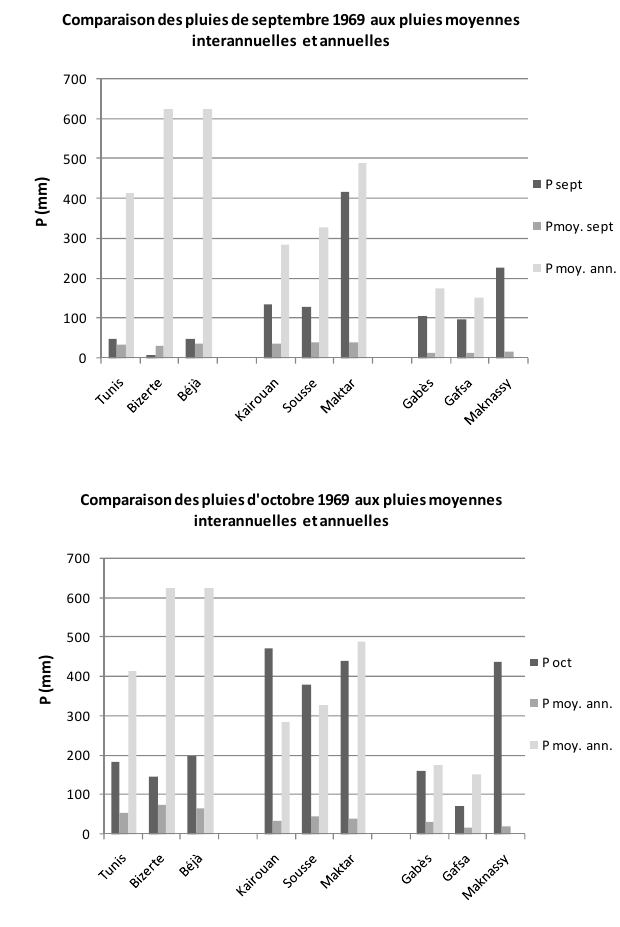
Figure 1. Précipitations des mois de Septembre et d’Octobre 1969 comparées aux précipitations mensuelles moyennes sur 60 années et aux précipitations annuelles moyennes sur 50 années (Pias, 1970).